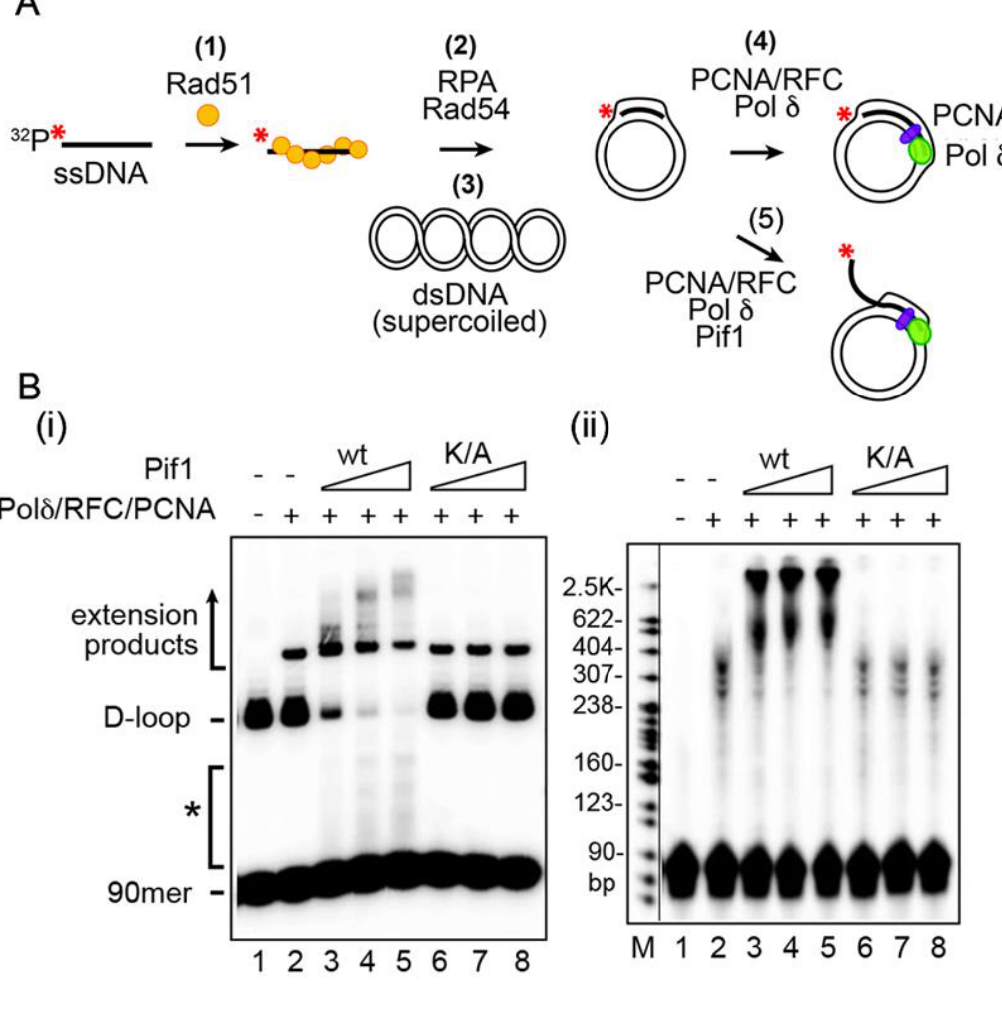
FIGURE 9: Effect of Pif1 DNA helicase on Pol  -mediated DNA synthesis. (A) Reaction scheme to examine the effect of S. cerevisiae Pif1 helicase on Pol  -mediated DNA synthesis. (B) Reactions conducted with PCNA-RFC- Pol δ in conjunction with Pif1 or the helicase -dead mutant pif1 K264A (K/A). Analysis was by (i) native gel electrophoresis and (ii) denaturing gel electrophoresis (7M urea, polyacrylamide) [114]. The asterisk identifies extended invading ssDNA species that had been released from the D-loop by Pif1. (The gel image is taken from